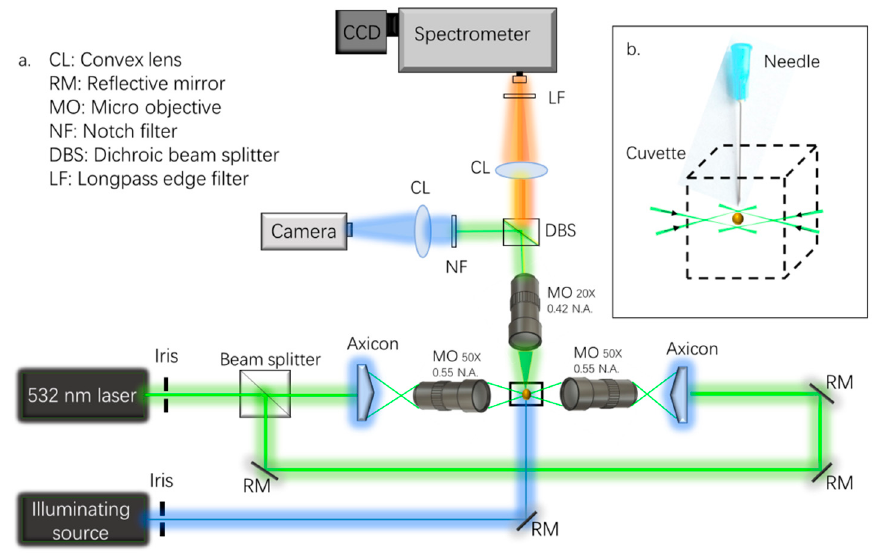
Figure 1. ( a ) The experimental setup of the OT-RS system; ( b ) the schematic shows a particle trapped in UOT.